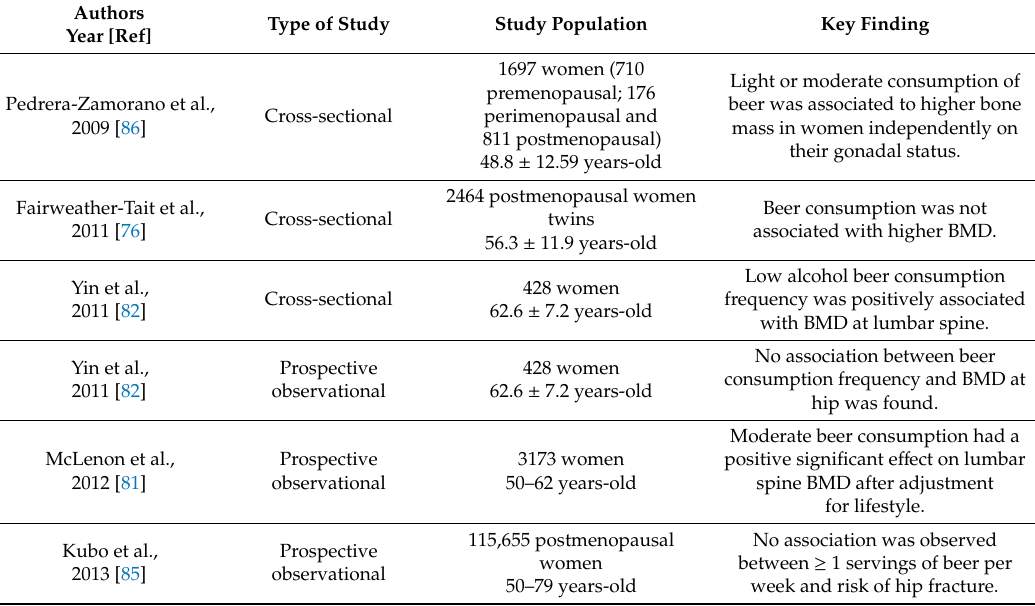
Table 3. Women studies evaluating the relationship between beer consumption and